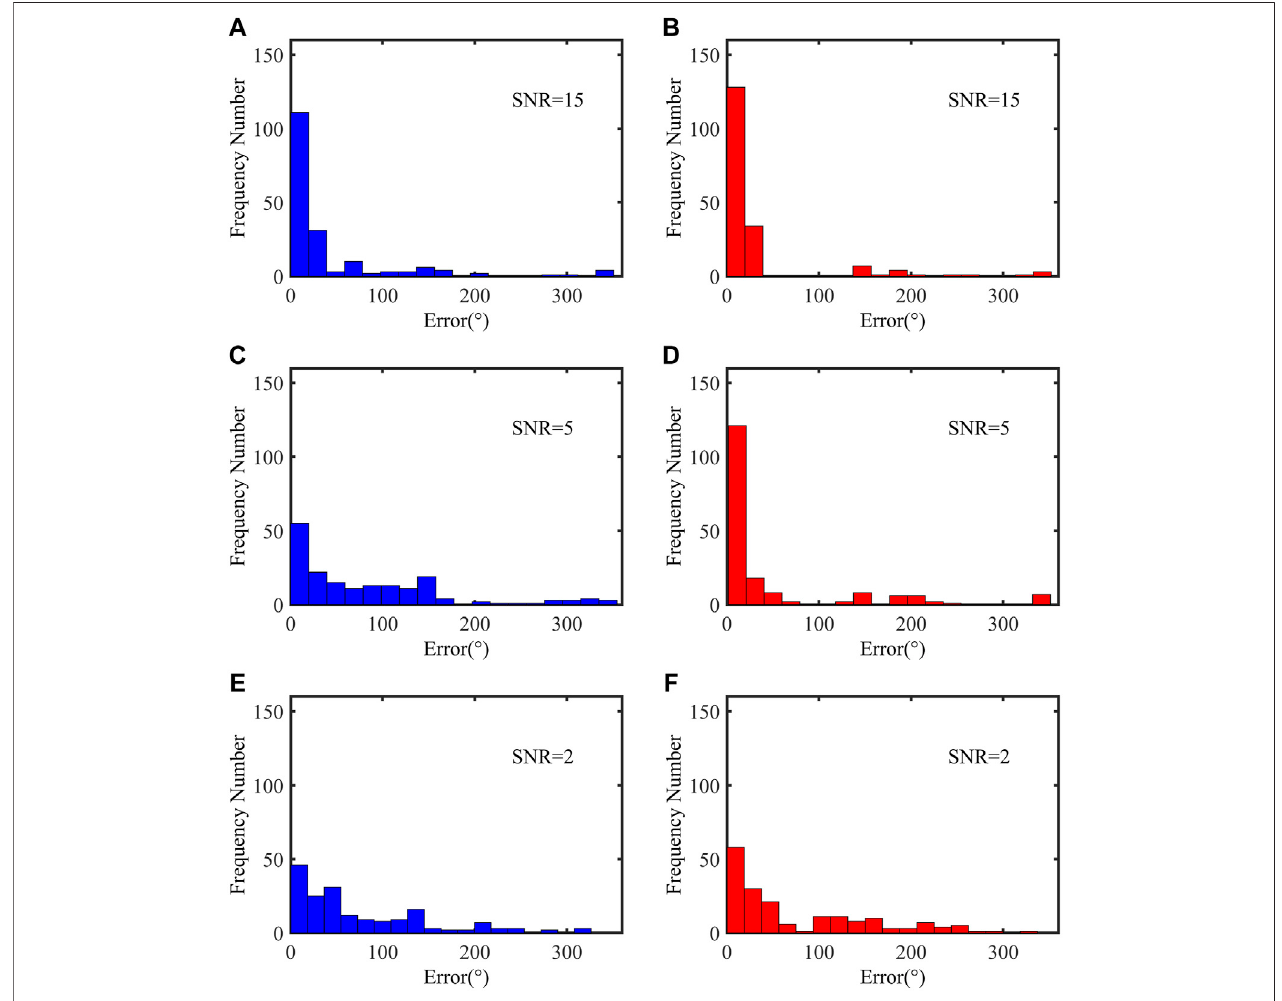
FIGURE6| Errorsinorientationresultsofallgeophonesforthesyntheticdata.TheSNRsof (A – B) , (C – D) ,and (E – F) are15,5,and2dB.Theleftcolumnshowsthe results obtained from the eigenvalue method, and the right column shows the results obtained using the scalar fi eld method.